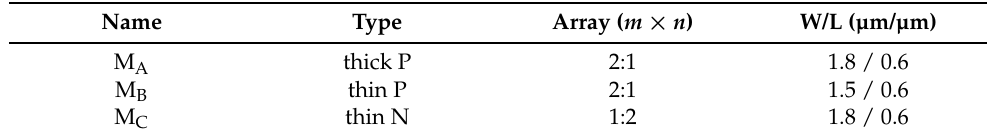
Table 1. Inverter cell transistor array dimensions.